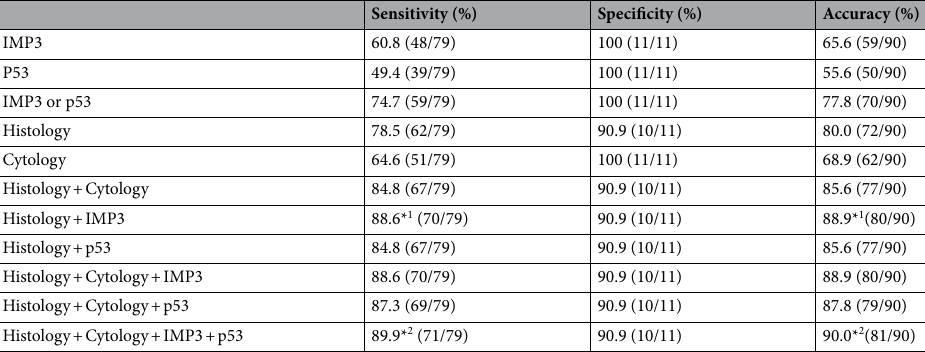
Table 3. Results of EUS–FNA (all cases). 1 P = 0.01, Histology vs. Histology + IMP3. 2 P = 0.13, Histology + Cytology vs. Histology + Cytology + IMP3 + p53. EUS–FNA, endoscopic ultrasound-guided fine- needle aspiration.